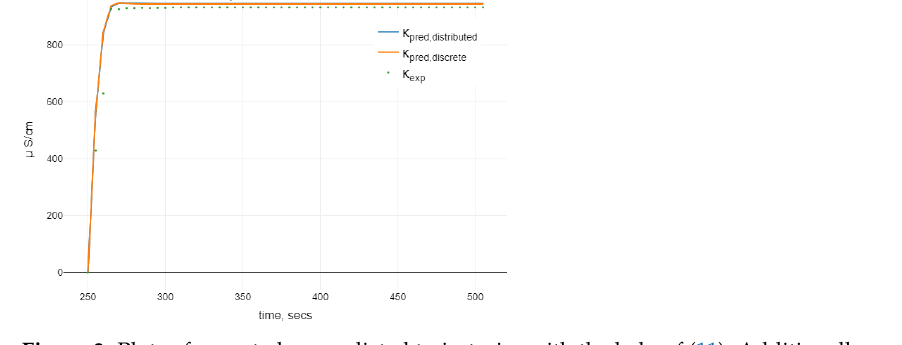
Figure 3. Plots of expected vs predicted trajectories with the help of (11). Additionally, a comparison of modeling with the help of Brown’s model (4) with discrete delay is shown: κ pred , distributed , κ pred , discrete κ exp . Table 1. Initial values and bounds for parameter identification based on the Algorithm 1. Column Π opt contains the solution of